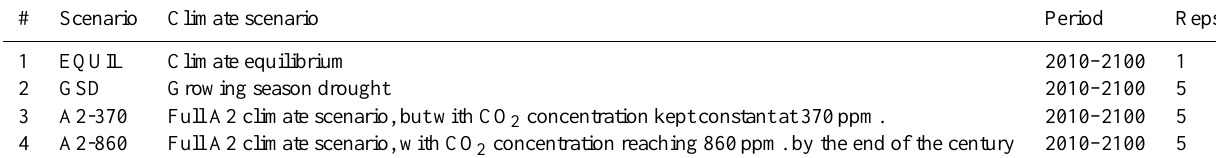
Table 4. Climate scenarios (reps. for randomized realizations of a climate scenario).